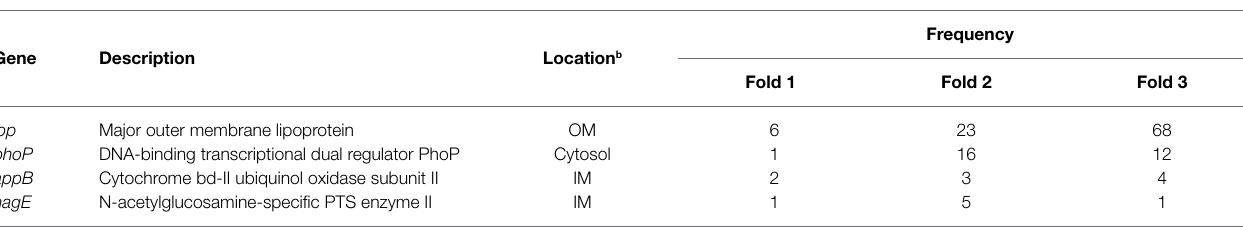
TABLE 2 | Genes exhibiting a high correlation with image feature elements a .